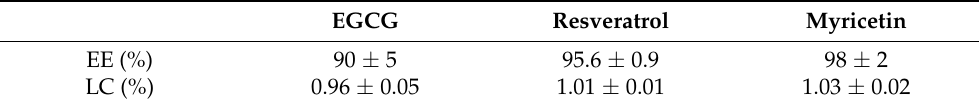
Table 1. Encapsulation efficiencies (EE) and loading capacity (LC) of EGCG, resveratrol and myricetin in the developed SLNs (mean ± SD, n =